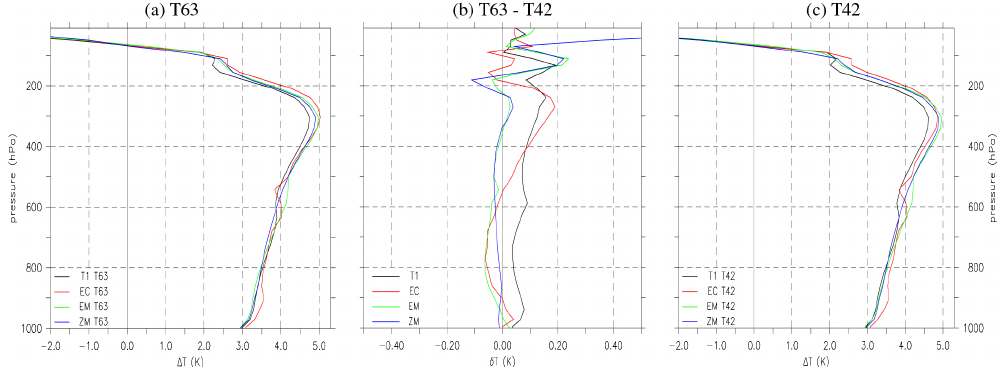
Figure 1. Temperature difference 1T of the global mean temperature profiles between the 2 × CO2 and REF simulations for different convection parameterisations and two resolutions (left panel: T63; right panel: T42). The figure in the middle displays the temperature difference of the two resolutions.